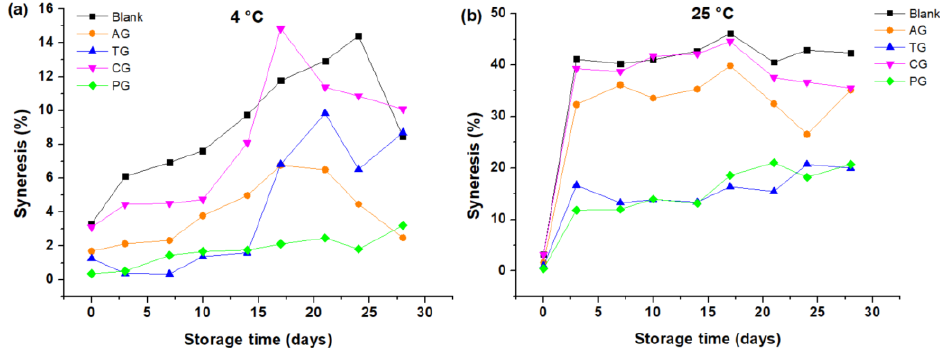
Figure 6. Syneresis as a function of storage time: ( a ) Creams stored at 4 °C; ( b ) Creams stored at 25 °C.